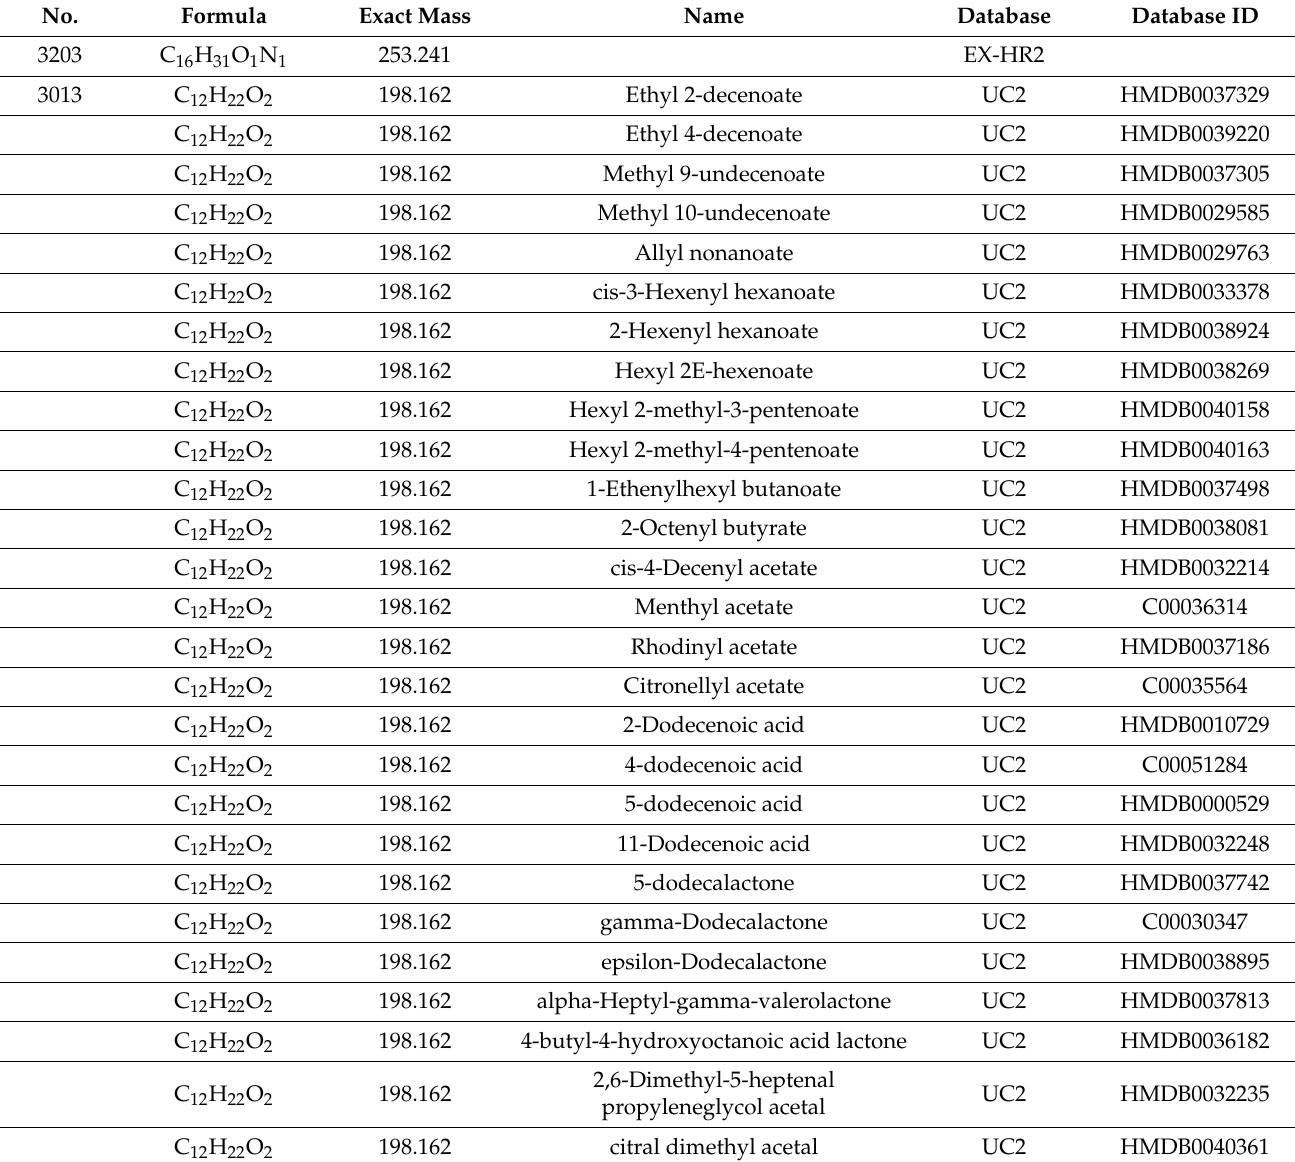
Table 1. The constituents in C. thermocellum MVs detected by LC-MS/MS